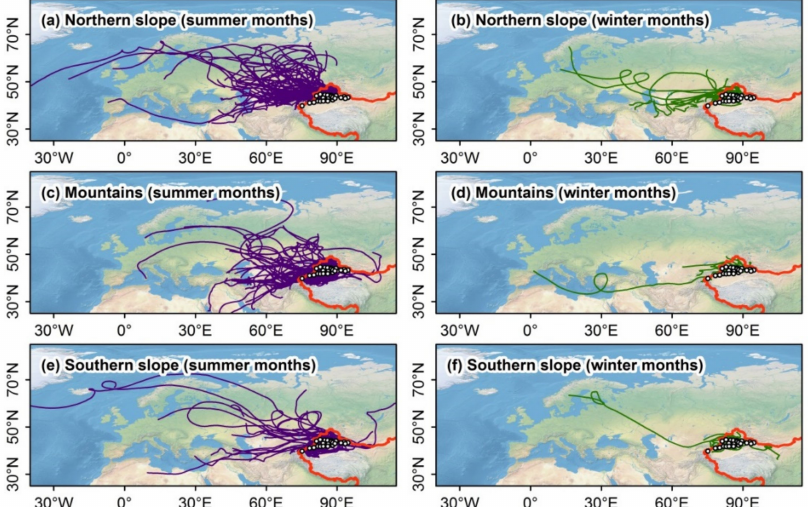
Figure 3. Spatial distribution of the specific humidity-adjusted backward trajectories for the sampling sites around the Tianshan Mountains during precipitation days.